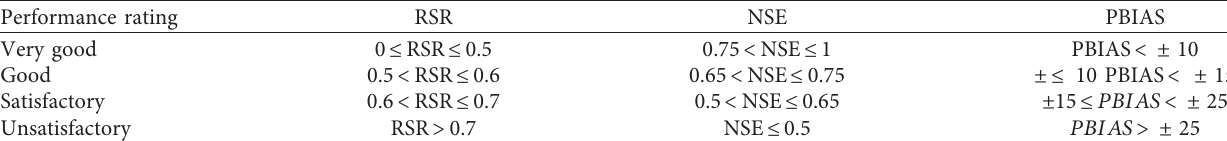
Table 6: Validation statistics.